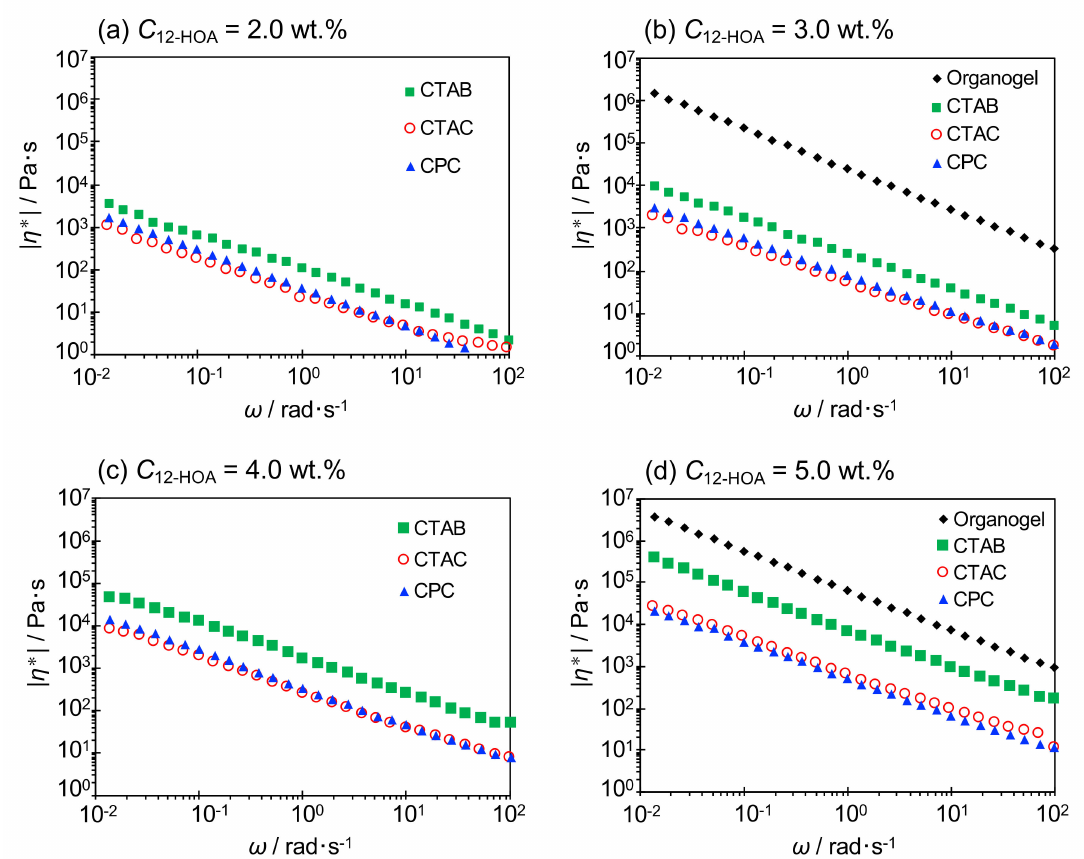
Figure 6. Absolute complex viscosity values of the hydrogels and organogel (n-decane / 12- hydroxyoctadecanoic acid (12-HOA)) as a function of the oscillatory shear frequency ( ω ) at 25 ◦ C. ( a ) C 12-HOA = 2.0 wt.%, ( b ) C 12-HOA = 3.0 wt.%, ( c ) C 12-HOA = 4.0 wt.% and ( d ) C 12-HOA = 5.0